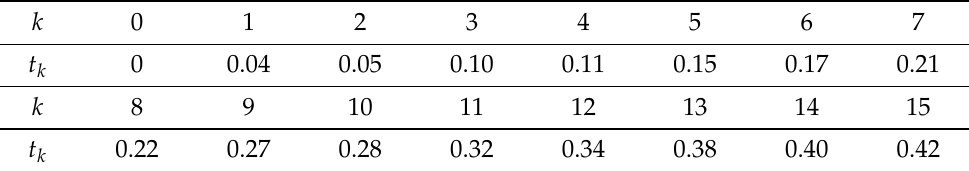
Table 2. The time sequence { t k }